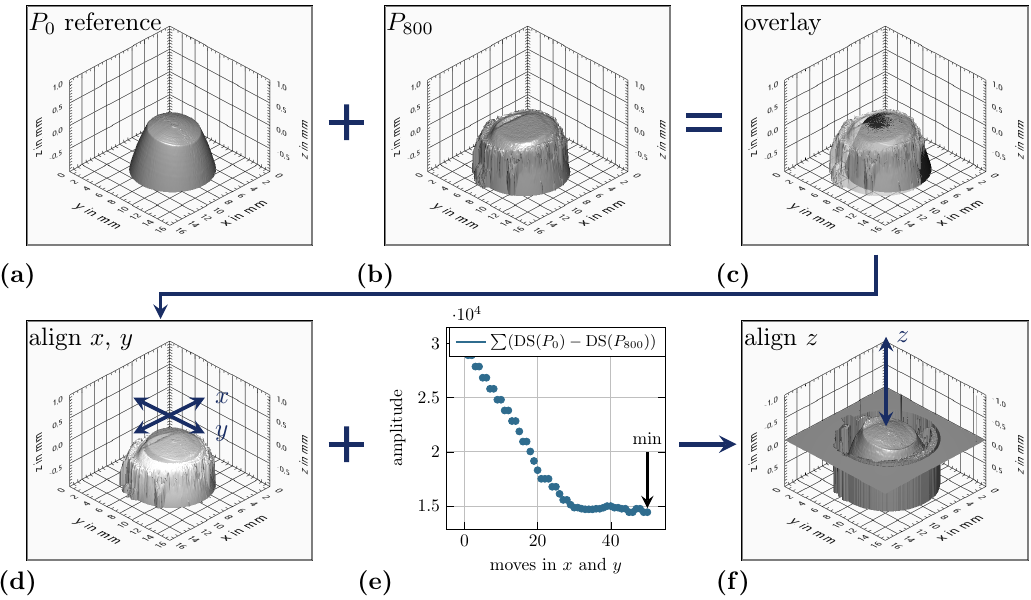
Figure 8. Procedure to align data sets (DSs) of 3D topographical measurements for comparison and determining ∆ h i .topo on example of MC01–TS01 P i = 0 and P i = 800 as 3D projection. ( a ) Plot of reference DS of P 0 ; ( b ) plot of DS to align; ( c ) overlay of both DSs; ( d , e ) aligned DS in x – y plane by determining minimal difference between two DSs; ( f ) aligned in z